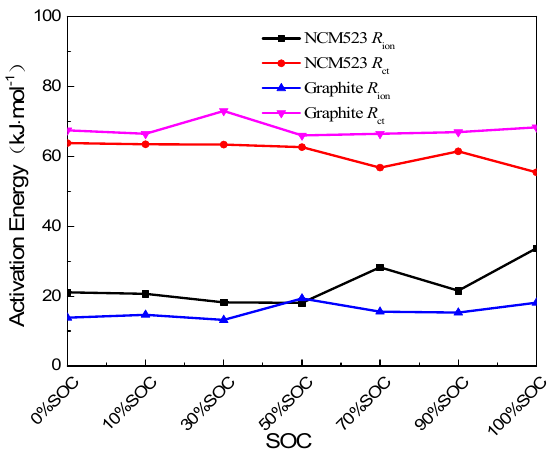
Figure 13. Ac tivation energy of R ion and R ct both for cathode and anode. Figure 13. Activation energy of R ion and R ct both for cathode and